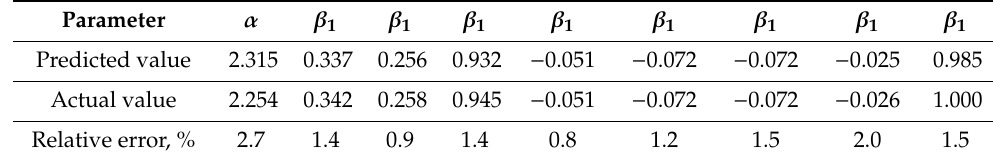
Table 3. Estimation results of formula parameters